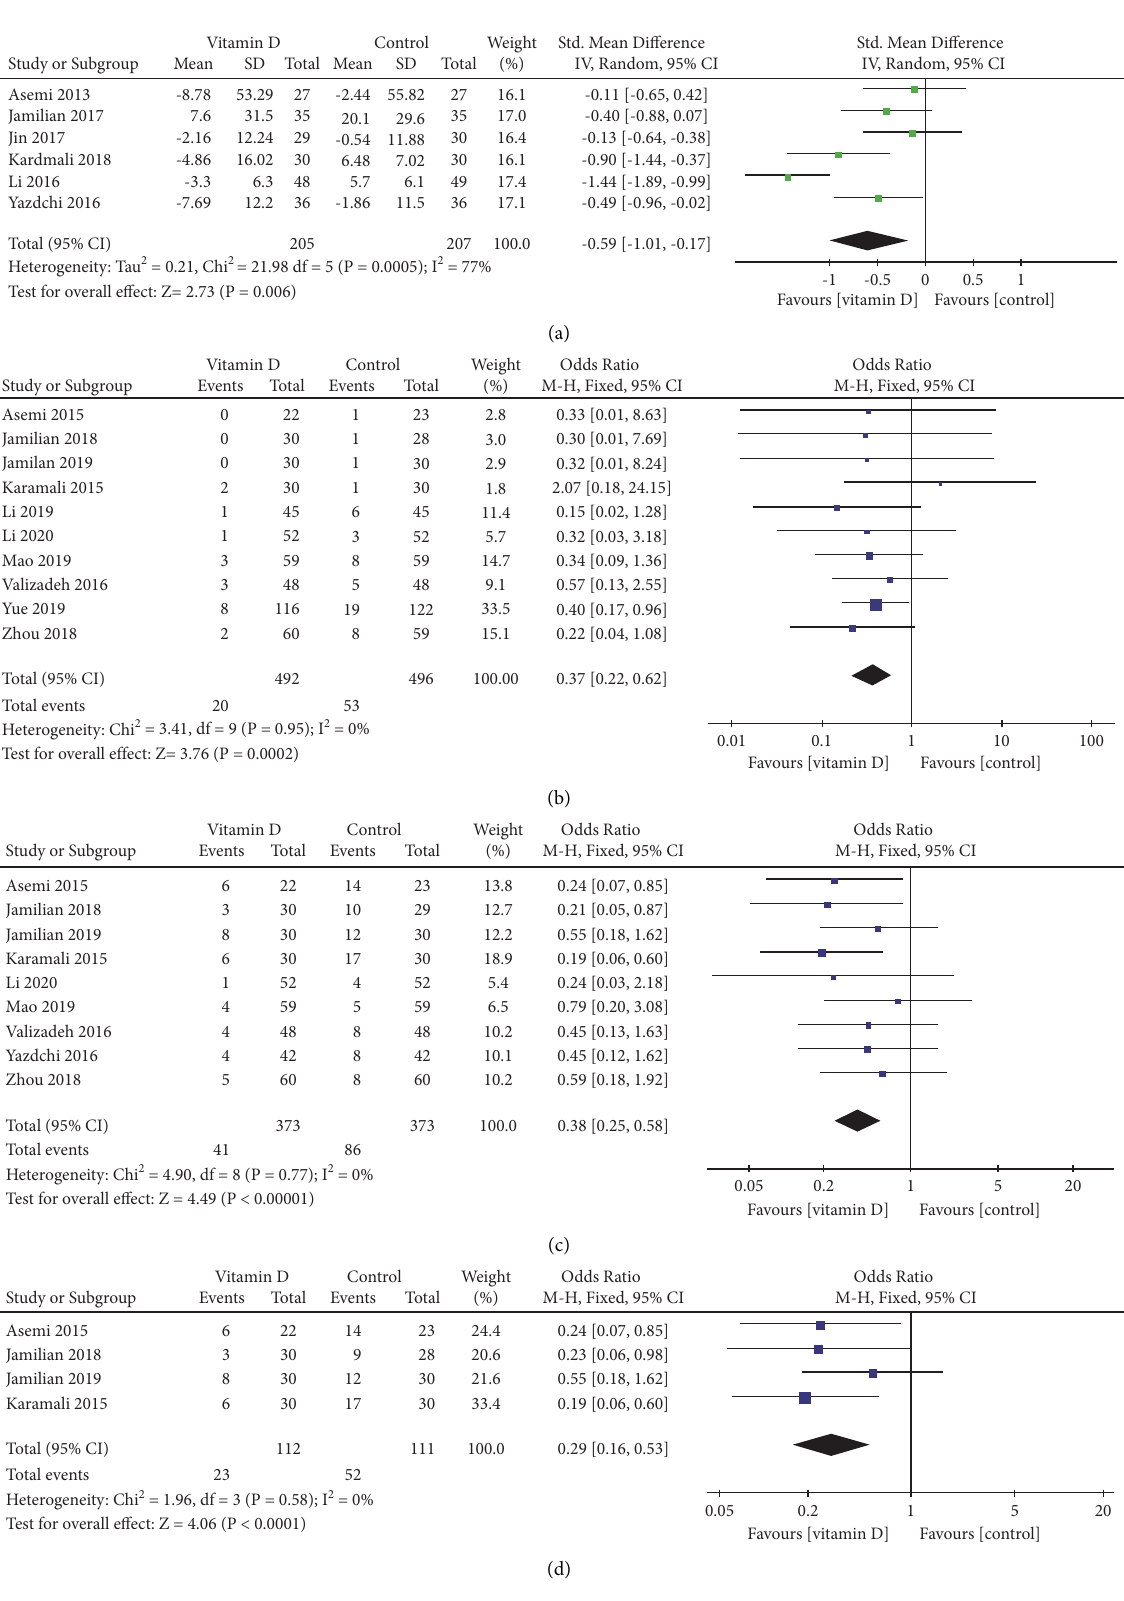
Figure 3: Forest plots for (a) the serum TG level and the incidence of (b) premature birth, (c) hyperbilirubinemia, and (d) neonatal